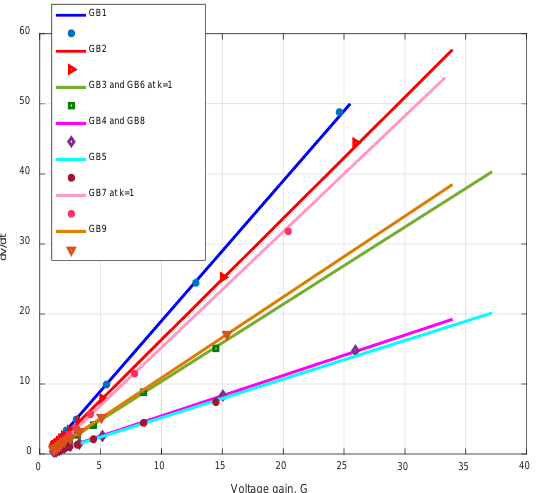
Figure 25. Normalized dv / dt value of CMV Versus G . Solid lines: theoretical results, marks: simulation results.